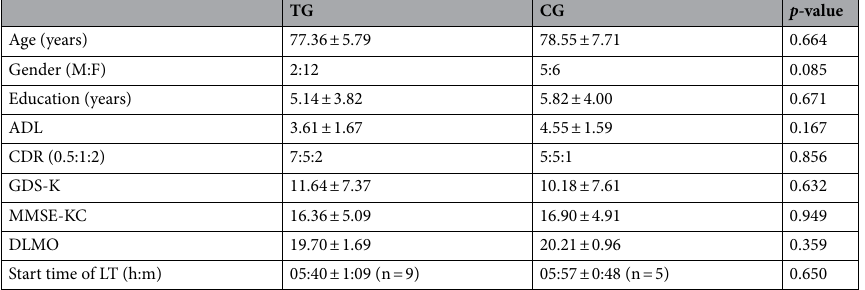
Korean version of the Cornell Scale for Depression in Dementia (CSDD-K) 37 . The CSDD-K was a 19-item tool designed to rate symptoms of depression for those with dementia. It had a cutoff score of 7 for depression in AD patients. Caregiver burden questionnaires. Zarit Burden Interview (ZBI-K) 29 . Caregiver burden was measured using